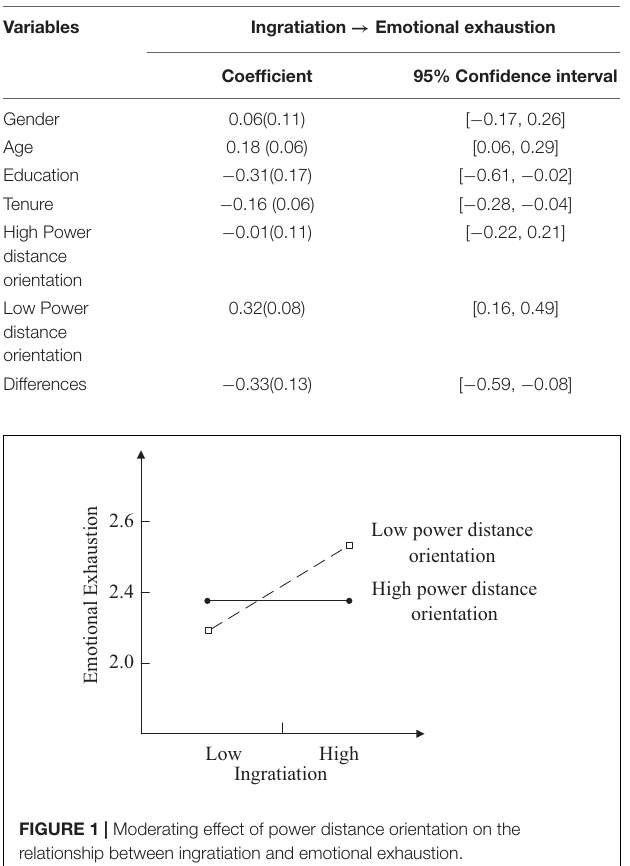
TABLE 6 | Results of moderated moderation effect